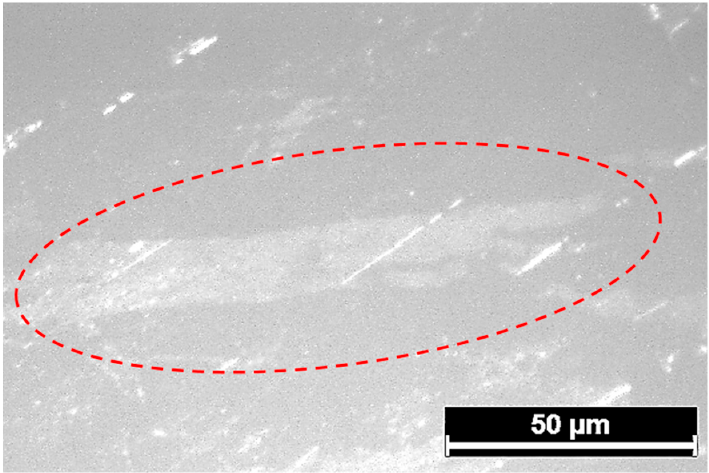
Figure 2. Optical microphotograph of thin film obtained from Ga–Sn–Zn eutectic alloy on glass (the layer has been circled).